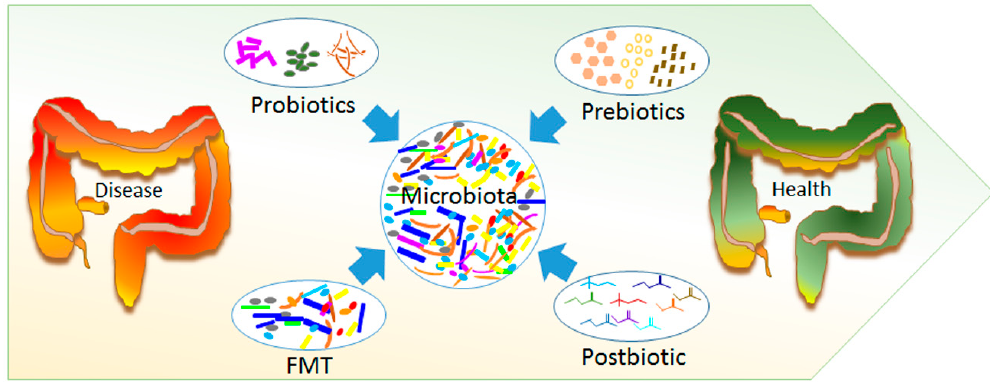
Figure 2. Gut microbiota modulation. Beneficial effect on the intestinal environment through microbial composition modification, by using probiotic, prebiotic, and postbiotic administration and fecal microbiota transplantation (FMT). All these approaches can be optimized by patient-tailored treatments for the better management of the individual’s physiology and pathology.